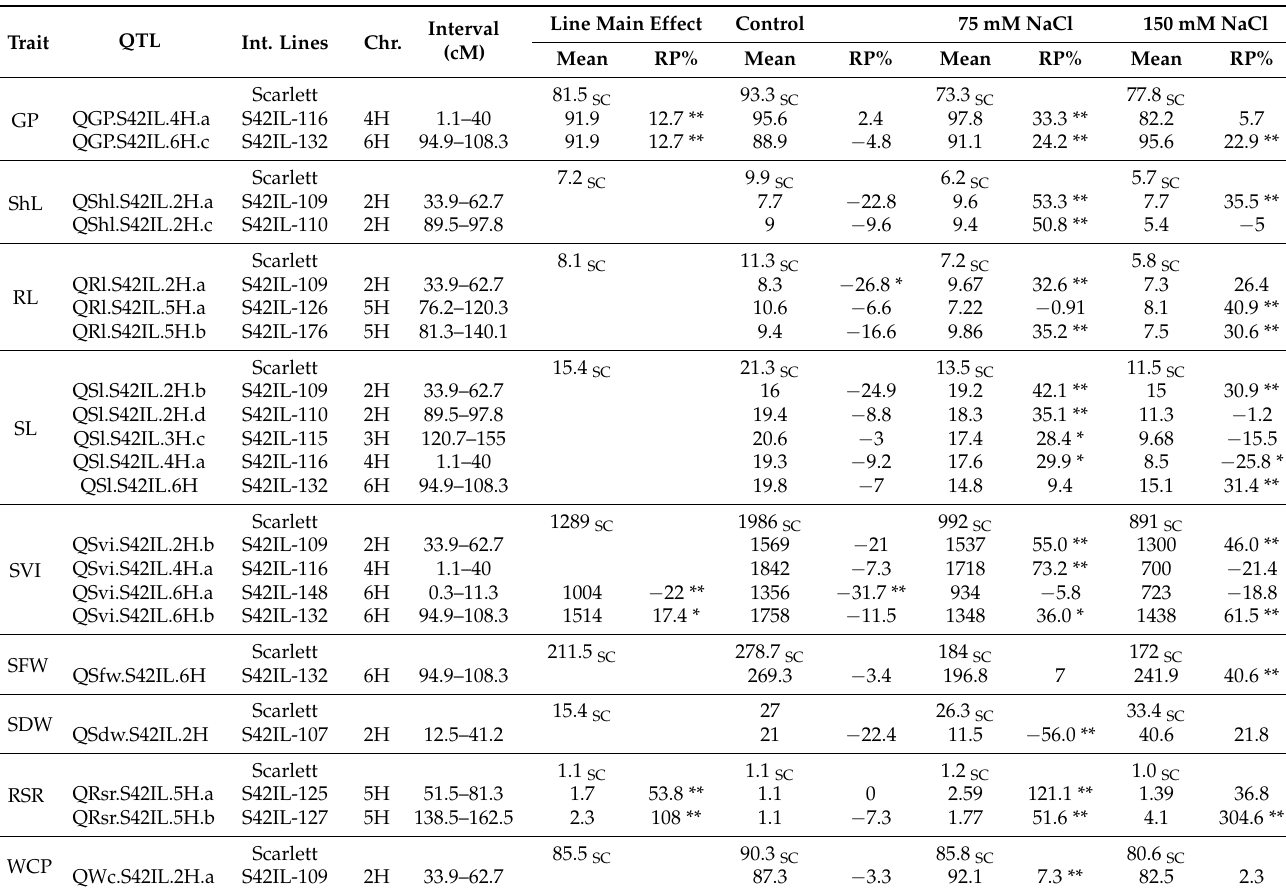
Table 4. Identification of putative QTL associated with salinity tolerance related traits at germination and seedling stages as line main effect and line by treatment